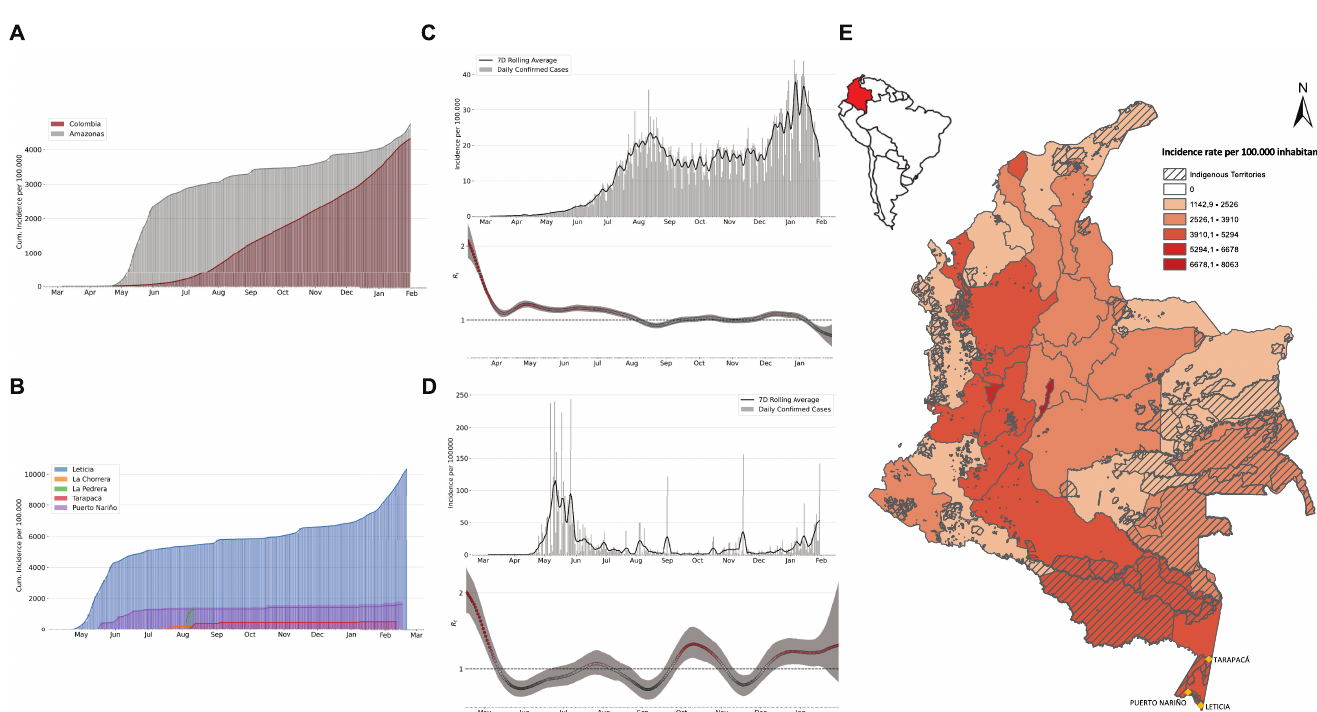
Fig 1. Epidemiological description of SARS-CoV-2 in the Colombian Amazonas department. A. Graphical representation of SARS-CoV-2 cumulative incidence in the Amazonas department and Colombia from March to January 30, 2021. The grey bars represent the cumulative incidence per 100.000 people in the Amazonas department and the red bars represent the cumulative incidence per 100.000 people in the rest of the country. B. Distribution of the cases in each of the municipalities in the Amazonas department including Leticia, Puerto Nari ñ o, La Pedrera, La Chorrera and Tarapaca´. C. - D. Estimates of the effective reproductive number (with a serial interval of 5.5 and variance of 4.5) where bars in the figure are reported cases in Colombia and the Amazonas department, respectively. The dots in the effective reproductive plot from grey to red show values of this quantity in time above 1 (red dots) and below 1 (grey dots). E. Incidence per 100,000 habitants by each Colombian department as of January 30, 2021. The hatched pattern demarcates national indigenous territories, and the yellow dots indicate the municipalities from where specimens were collected (Leticia, Puerto Nari ñ o, and Tarapaca´). The map was constructed in QGIS (QGIS Geographic Information System, Open-Source Geospatial Foundation Project, http://qgis.osgeo.org with the layer from the link: https://data-agenciadetierras.opendata.arcgis.com/datasets/fc3fc9592dd8460faf2b7f0bad0f8b33_0.